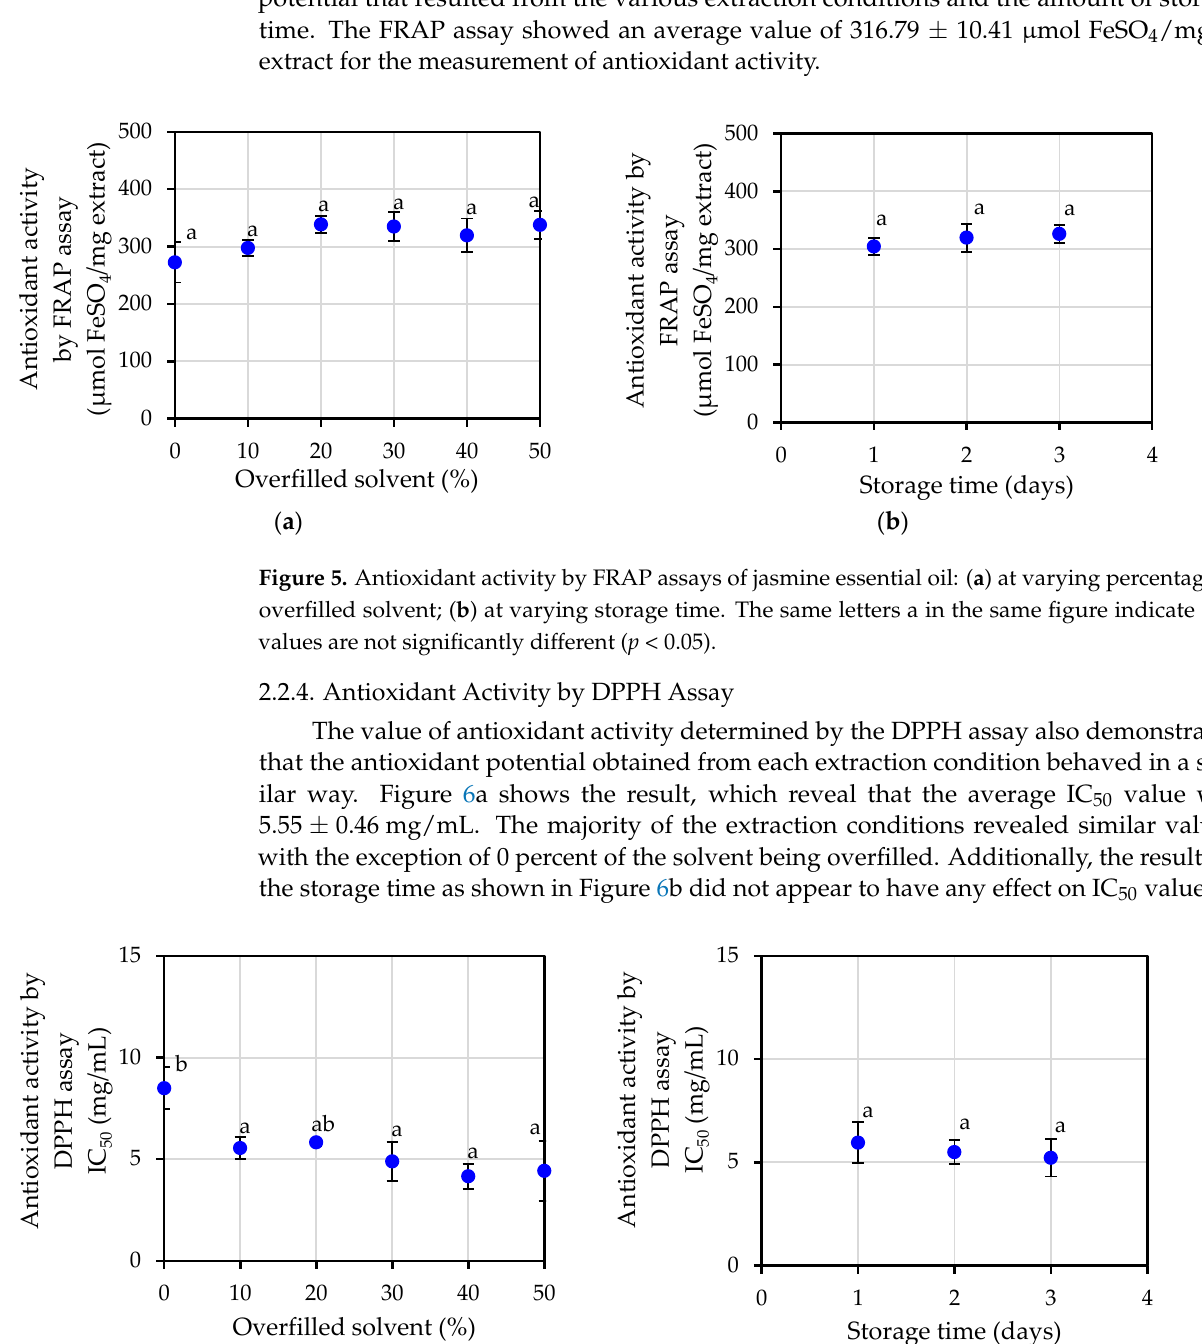
Figure 4. Total flavonoid content of jasmine essential oil: ( a ) at varying percentage of overfilled sol- vent; ( b ) at varying storage time. The same letters a in the same figure indicate that values are not significantly different ( p < 0.05).